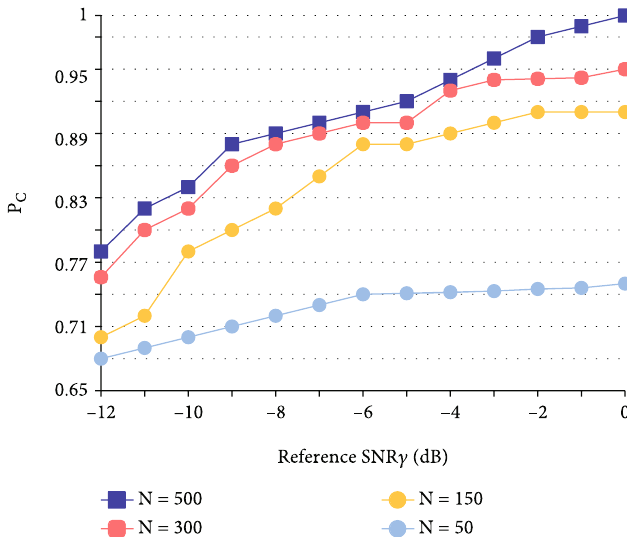
Figure 6: The in fl uence of the number of symbols on the algorithm based on the likelihood function. 00.30.40.50.60.70.80.9 P C